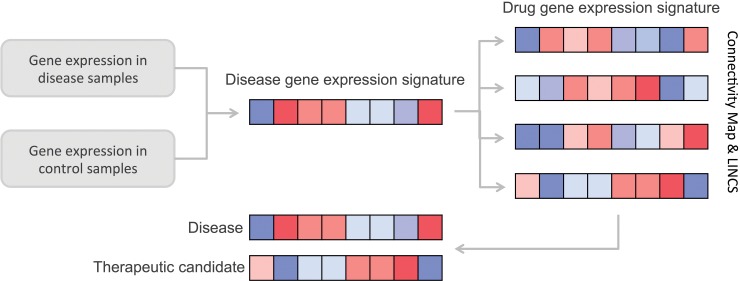
Analysis pipeline.In the first step gene expression values are compared between disease and control sample sets, resulting in a disease-derived gene expression signature. Next the disease expression signature is used to query databases of signatures associated with a variety of compounds. Compounds demonstrating an expression signature oppositional (anti-correlating) to that of the disease are suggested as possible therapeutic candidates.